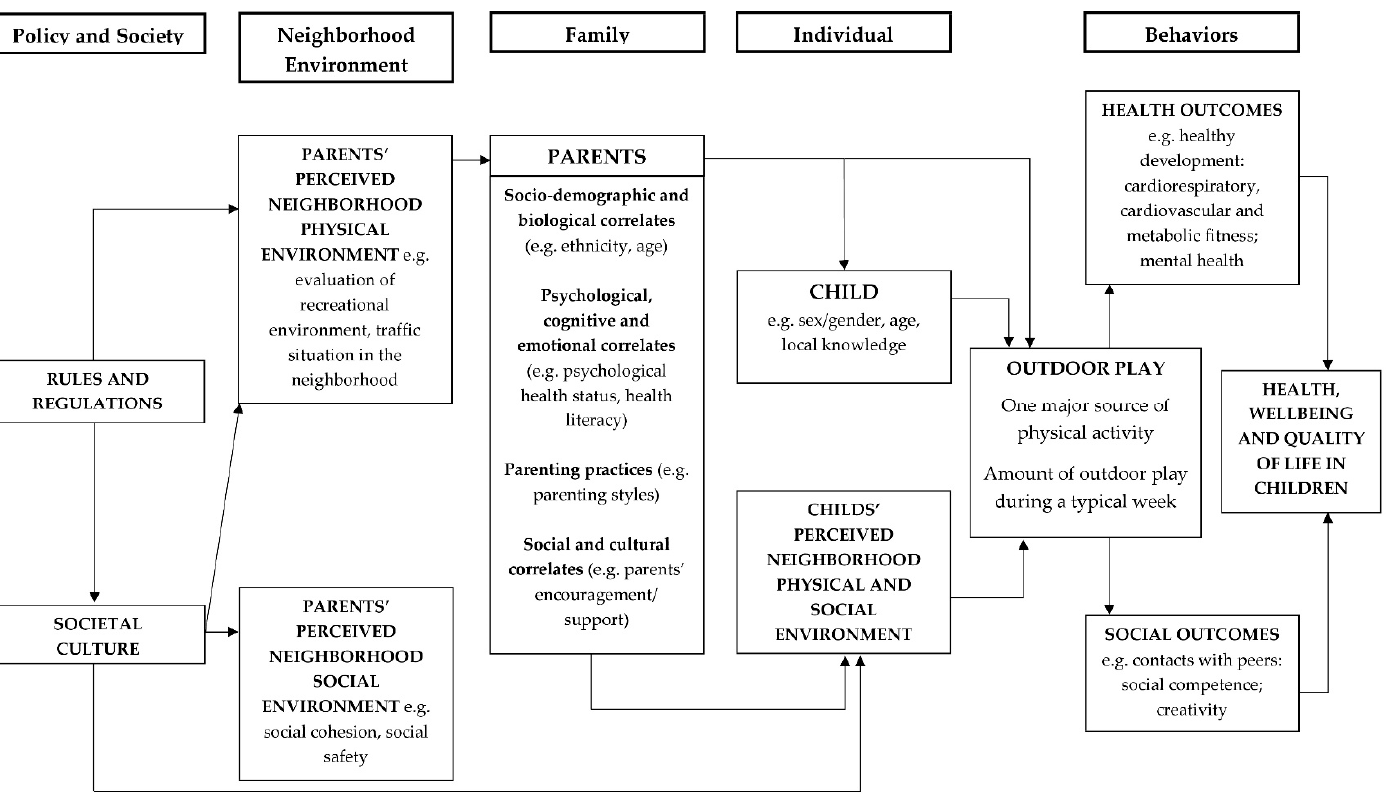
Figure 1. Socio-ecological model of different levels of influence on outdoor play in children (according to Sallis et al. [21]).